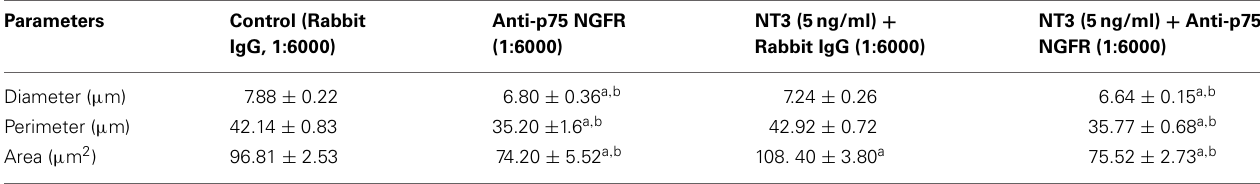
Table 2 | Summary of morphological analysis of GnRH neurons from treated nasal explants. Parameters